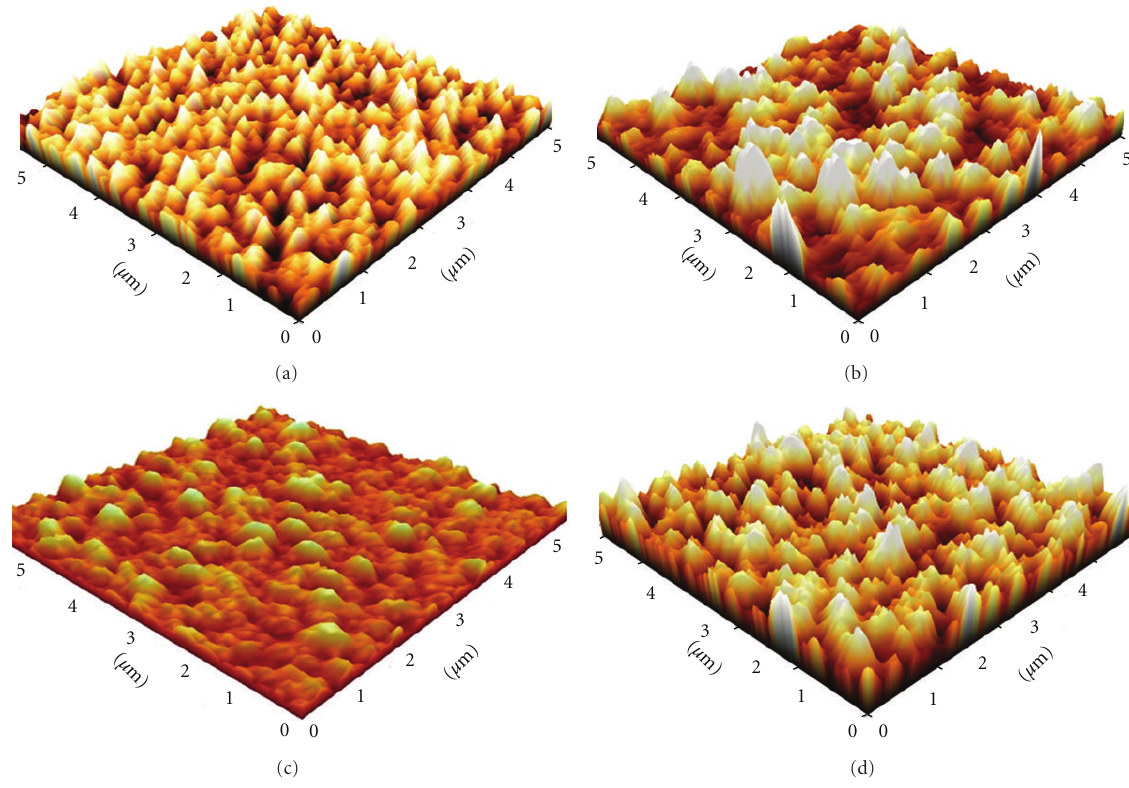
Figure 5: AFM morphologies of the ITiO film at di ff erent Ar gas pressures. (a) 5mTorr, (b) 10mTorr, (c) 15mTorr, (d) 20mTorr.